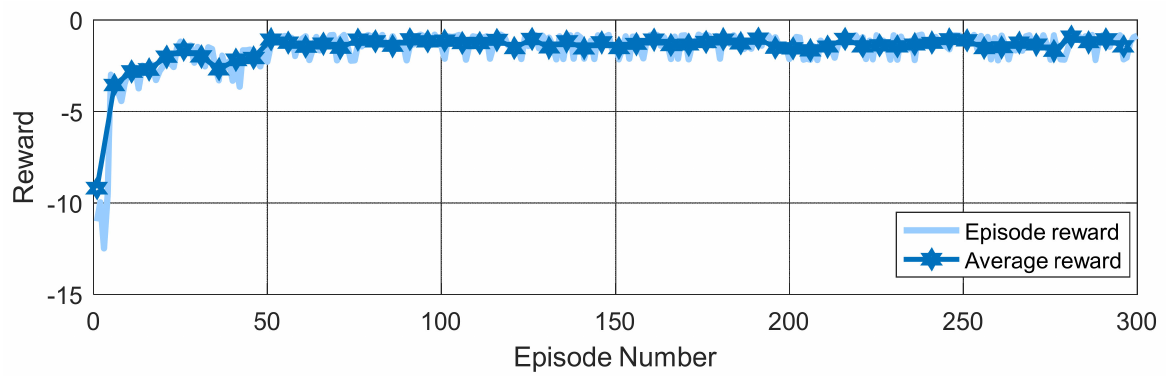
Figure 7. The rewards of DRL agents during the training